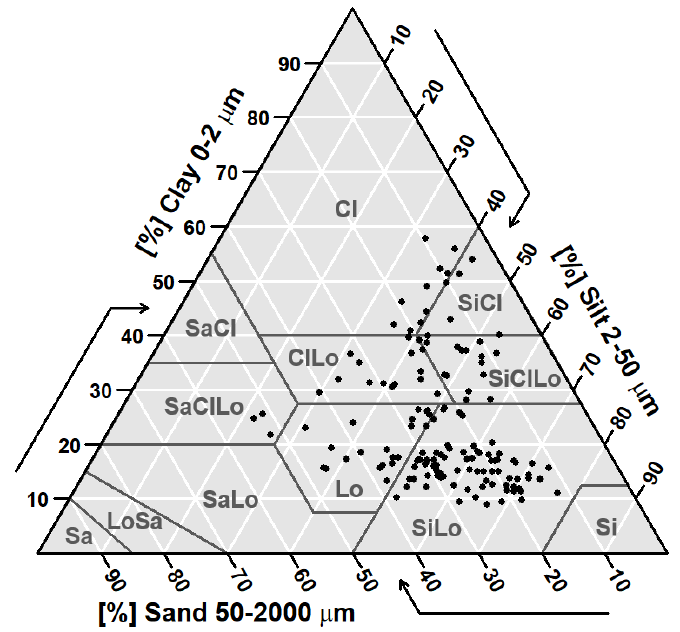
Figure 4. Surface texture measurements (black dots) displayed on the United States Department of Agriculture (USDA) classification system with the following classes: clay (Cl), silty clay (SiCl), sandy clay (SaCl), clay loam (ClLo), silty clay loam (SiClLo), sandy clay loam (SaClLo), loam (Lo), silty loam (SiLo), sandy loam (SaLo), silt (Si), loamy sand (LoSa) and sand (Sa).